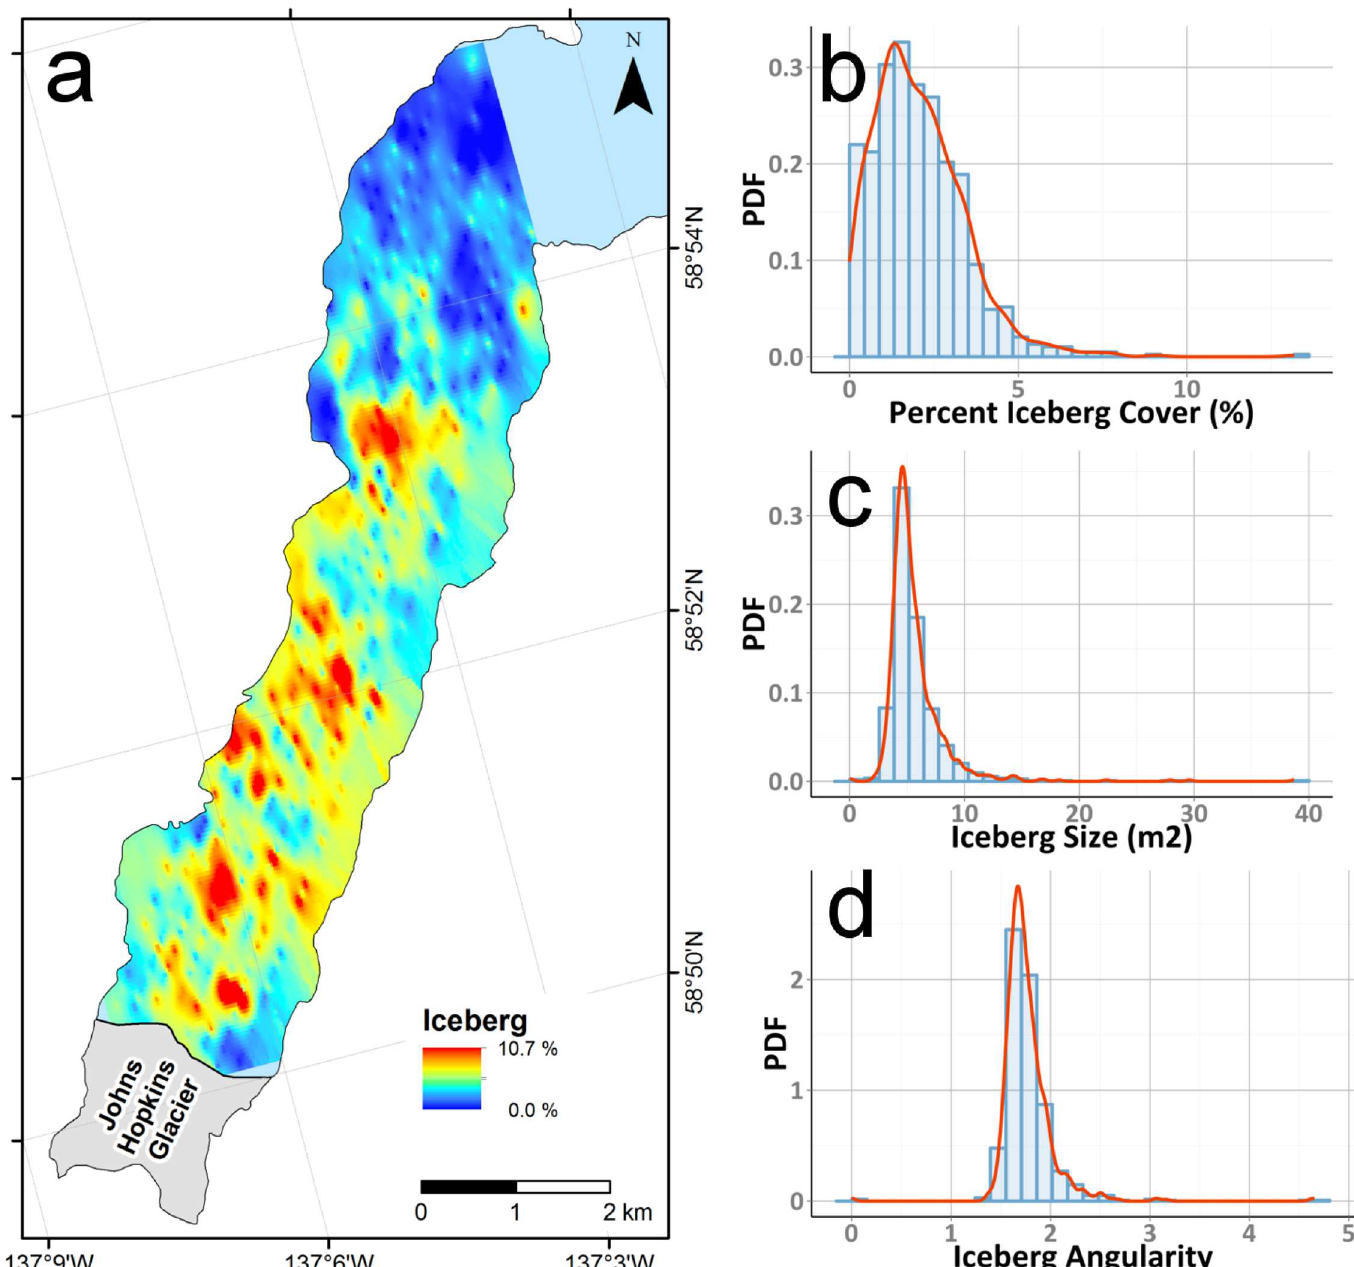
Fig 4. Spatial and numerical distribution of icebergs and characteristics within Johns Hopkins Inlet. (a) Distributionof icebergs ( > 1.6 m 2 ) within Johns HopkinsInlet on 18 June 2007, as a percentageof each aerial image. Iceberg data are interpolatedfrom non-overlappingimages. Histograms (blue) and probabilitydensity functions (red) for (b) percent iceberg cover, (c) mean icebergsize (in m 2 ), and (d) mean icebergangularity,